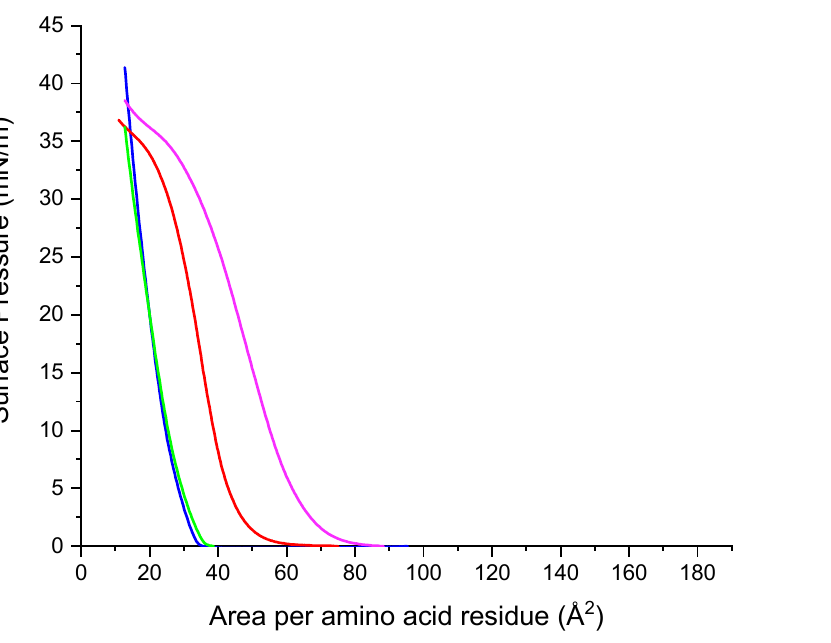
Figure 13. Isotherms of zein/Gemini arginine surfactants. zein (red line), zein/C 3 (LA) 2 mixture (blue line), zein/C 6 (LA) 2 mixture (green line), zein/C 9 (LA) 2 mixture (purple line).